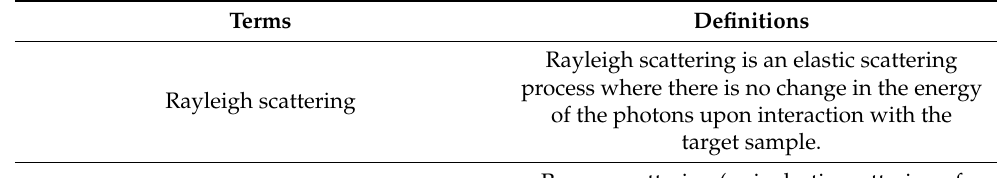
Table 1. Glossary of Raman Spectroscopy